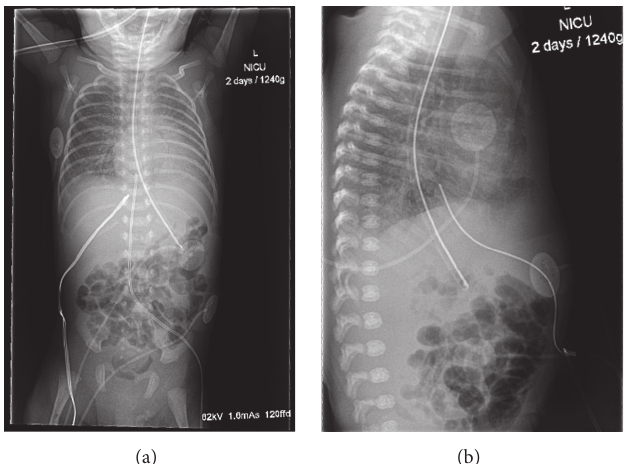
Figure 3: AP and lateral chest and abdomen X-rays taken after onset of SVT. The tip of the catheter is seen to have migrated into the right